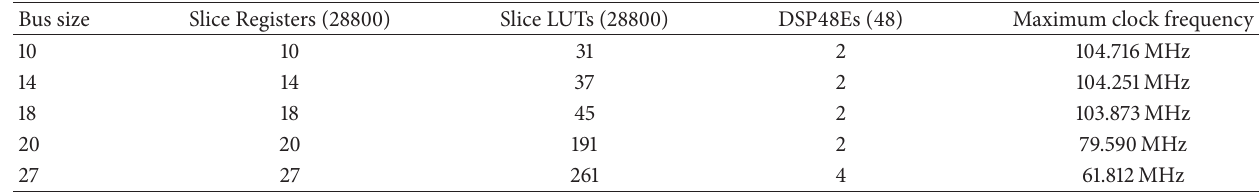
Table 2: Synthesis results of the stream cipher system.